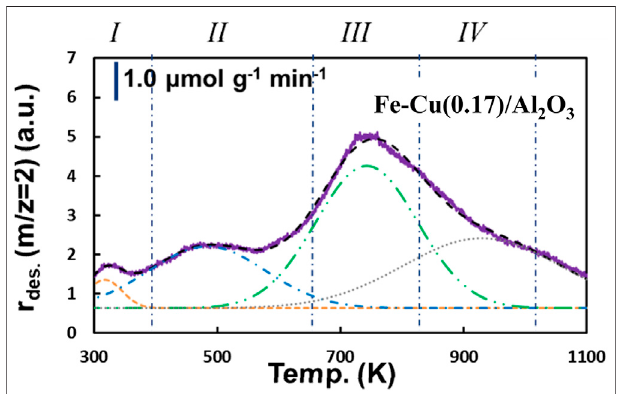
FIGURE 8 | Typical peak deconvolution of H 2 -TPD pro fi le obtained on the Fe-Cu(0.17)/Al 2 O 3 catalyst.